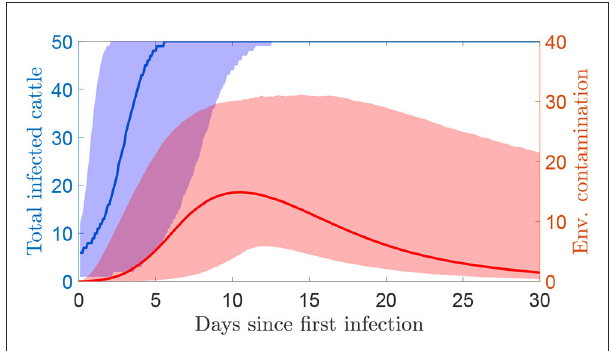
FIGURE1 The simulated number of infected cattle and the total environmental contamination over time since the first infections using the transmission model (median and 95% prediction interval). Environmental contamination is taken as the sum of the measures at each of the four locations. The herd size is 50